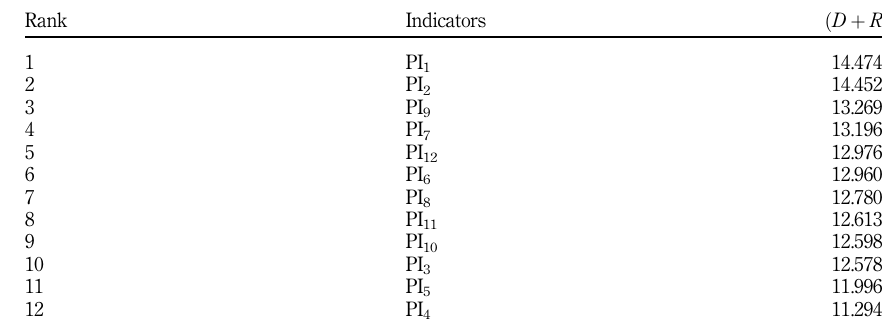
Table 6. Prominence vector of PIs